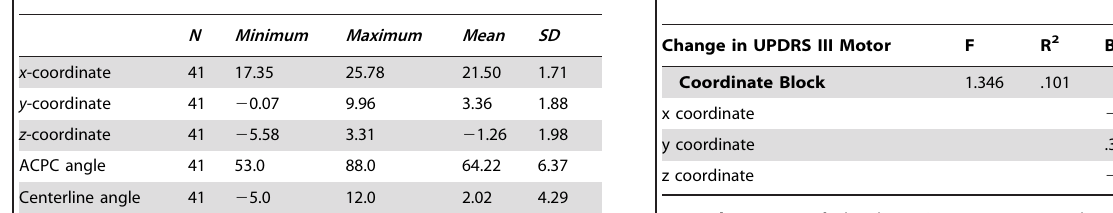
Table 4. Summary of Active Contact Data in GPi Patients.